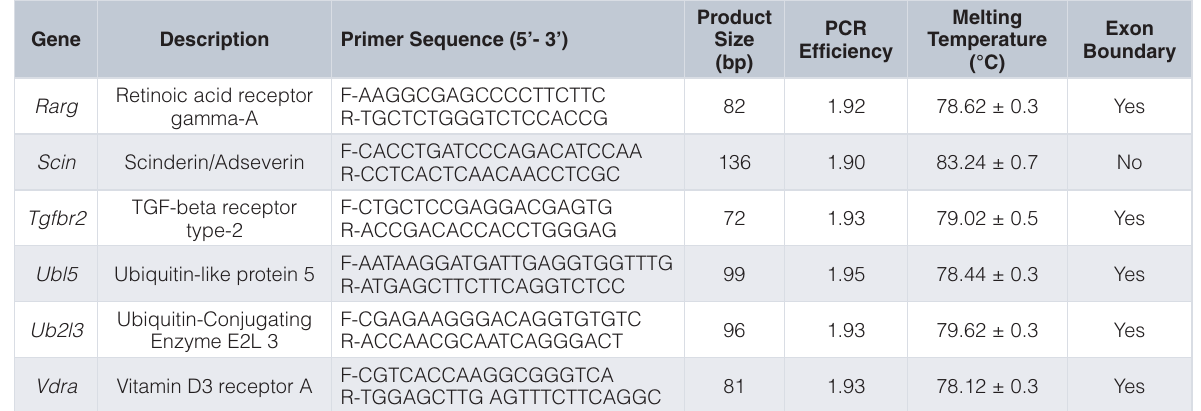
Supplemental Table S1 B.